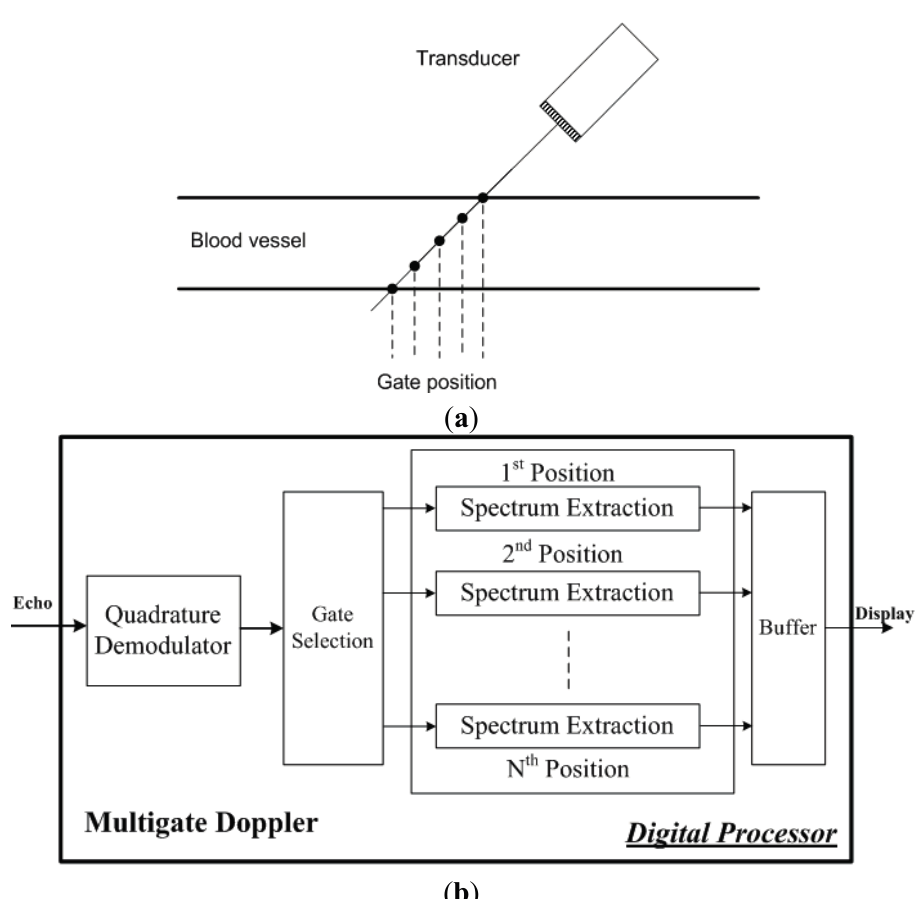
Figure 3. ( a ) Data acquisition scheme for multigate PW Doppler imaging; ( b ) Algorithms of multigate PW Doppler imaging achieved in a digital